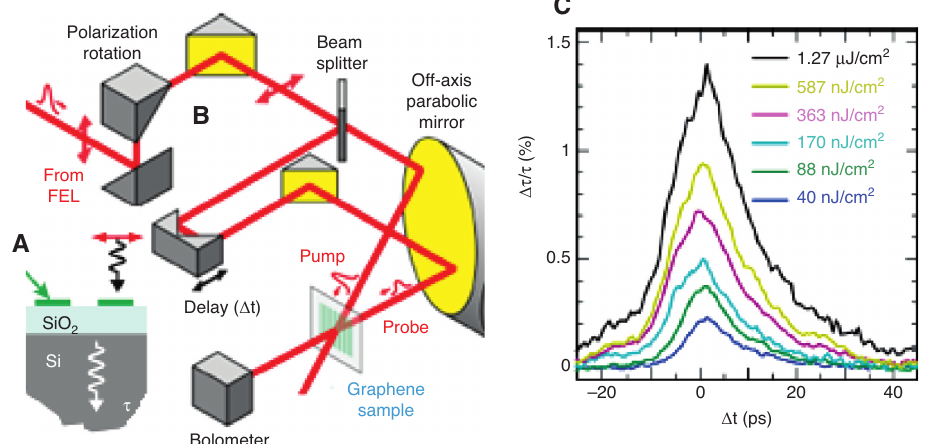
Substrate [133]. 2 . (B) Experimental setup for the pump-probe measurements. 2